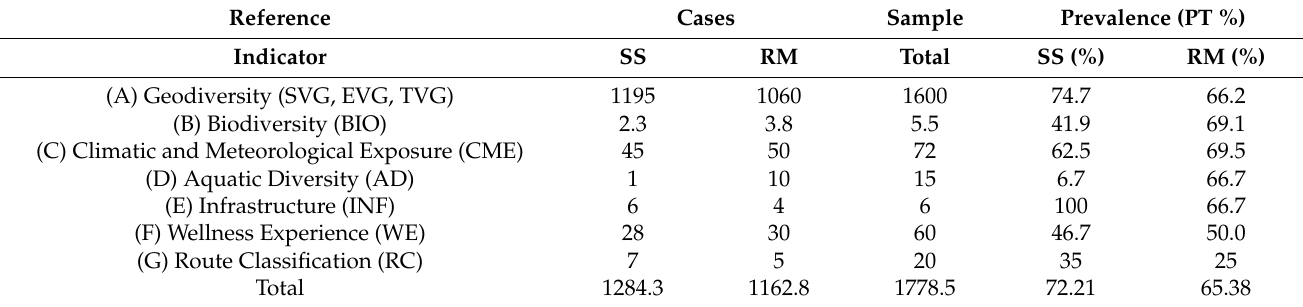
Table 7. Prevalence of indicators in the Santo Sepulcro and Riacho do Meio trails.